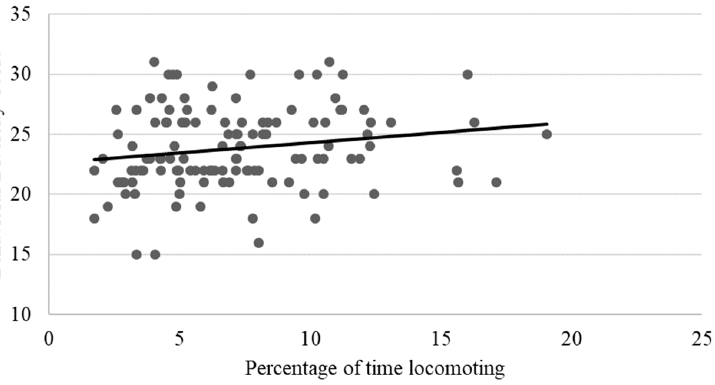
Figure 8. Positive relationship between behavioral diversity scores and mean percentage of time spent locomoting. Chimpanzees that spent more time locomoting had higher behavioral diversity scores (i.e., exhibited a higher number of different positive welfare behaviors) ( p ≤ 0.05).